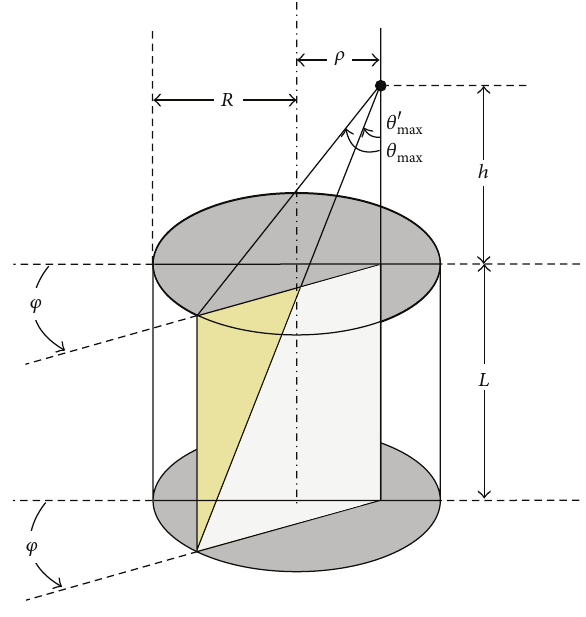
Figure 1: Point source configuration with 𝜌 ≤ 𝑅